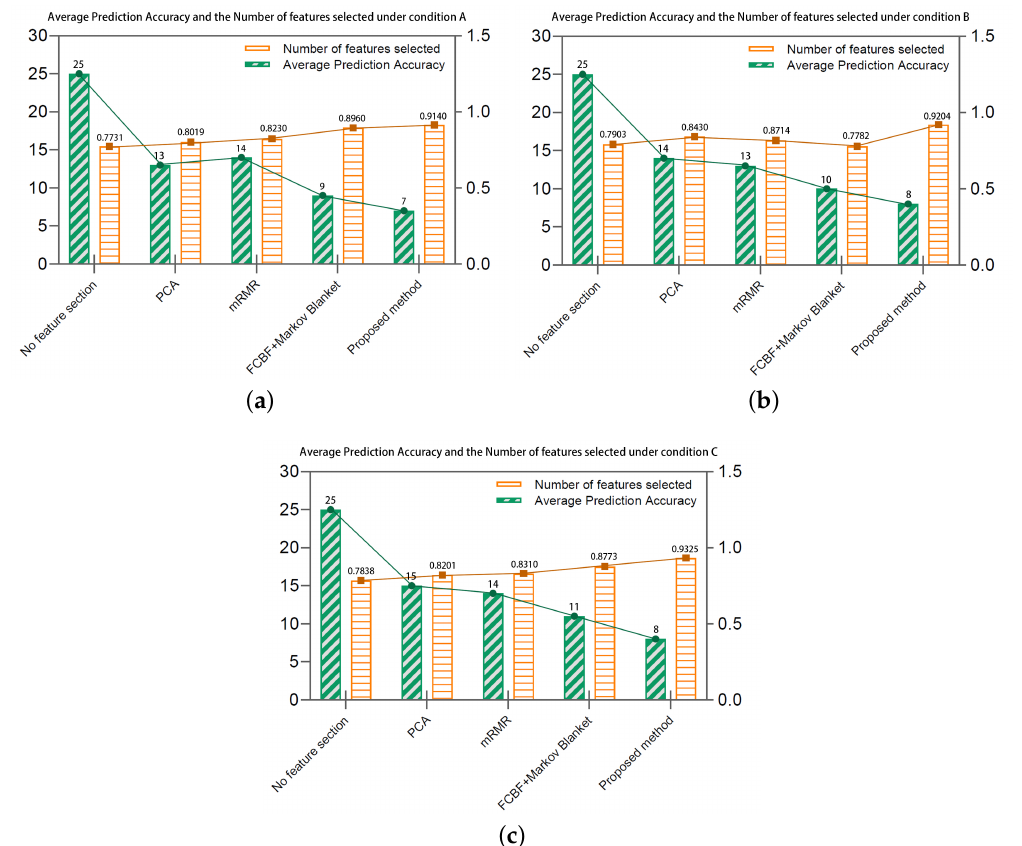
Figure 12. Average prediction accuracy and number of features selected under three operating conditions. ( a ) average prediction accuracy and the number of features selected under condition A, ( b ) average prediction accuracy and the number of features selected under condition B, ( c ) average prediction accuracy and the number of features selected under condition